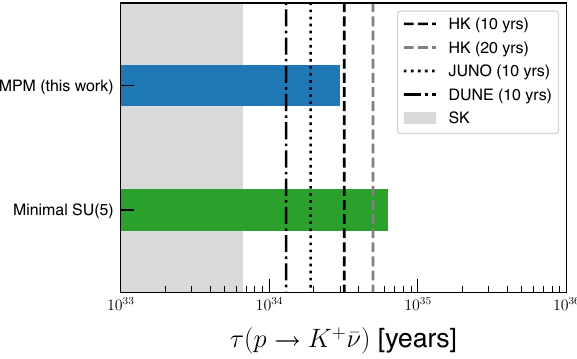
Fig. 13 The ranges of p → K + ν lifetimes found here in the CMSSM for the super-GUT MPM (blue band) and in the minimal SU(5) (green band; see Ref. [36]) compared with the sensitivities of the JUNO [65], DUNE [66] and Hyper-K [67] experiments. The gray shaded area is excluded by the Super-Kamiokande experiment [51,52]